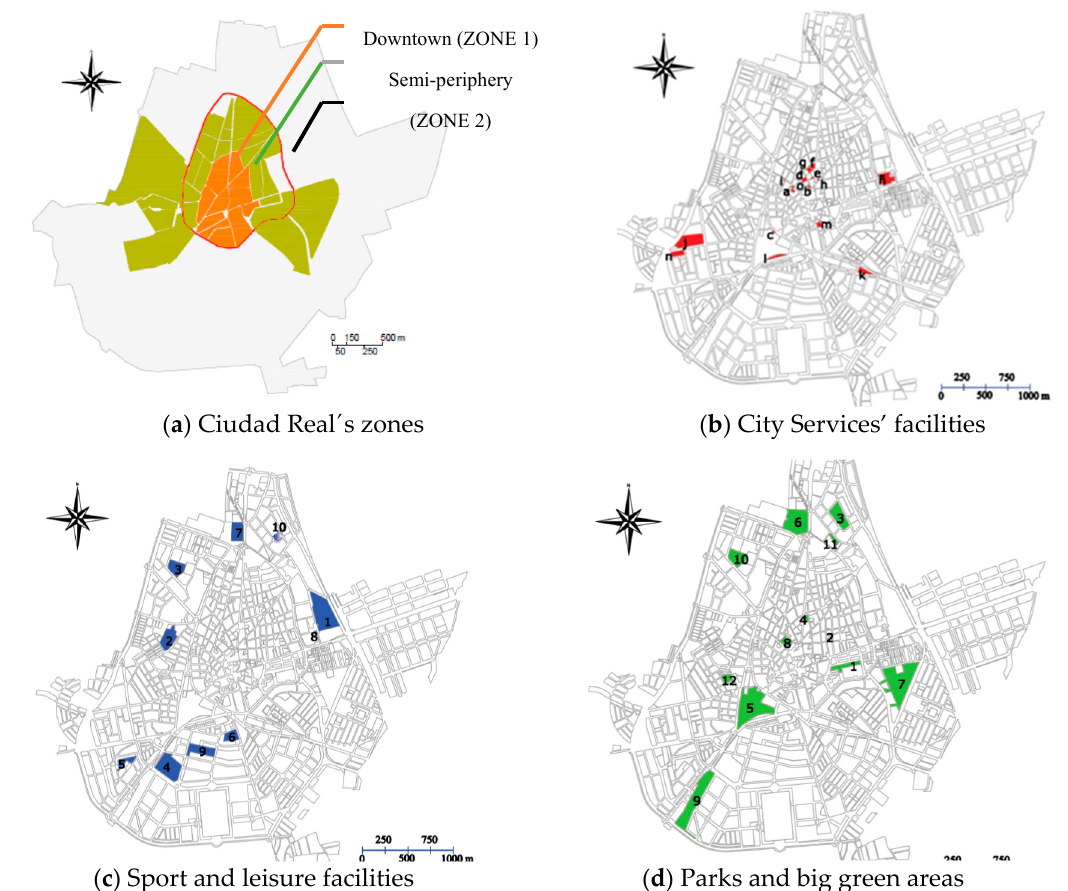
Figure 2. General zones and facility distribution of Ciudad Real: ( a ) Ciudad Real´s zones; ( b ) City Services’ facilities. This scheme shows: a. López Villaseñor Museum; b. Provincial museum; c. Don